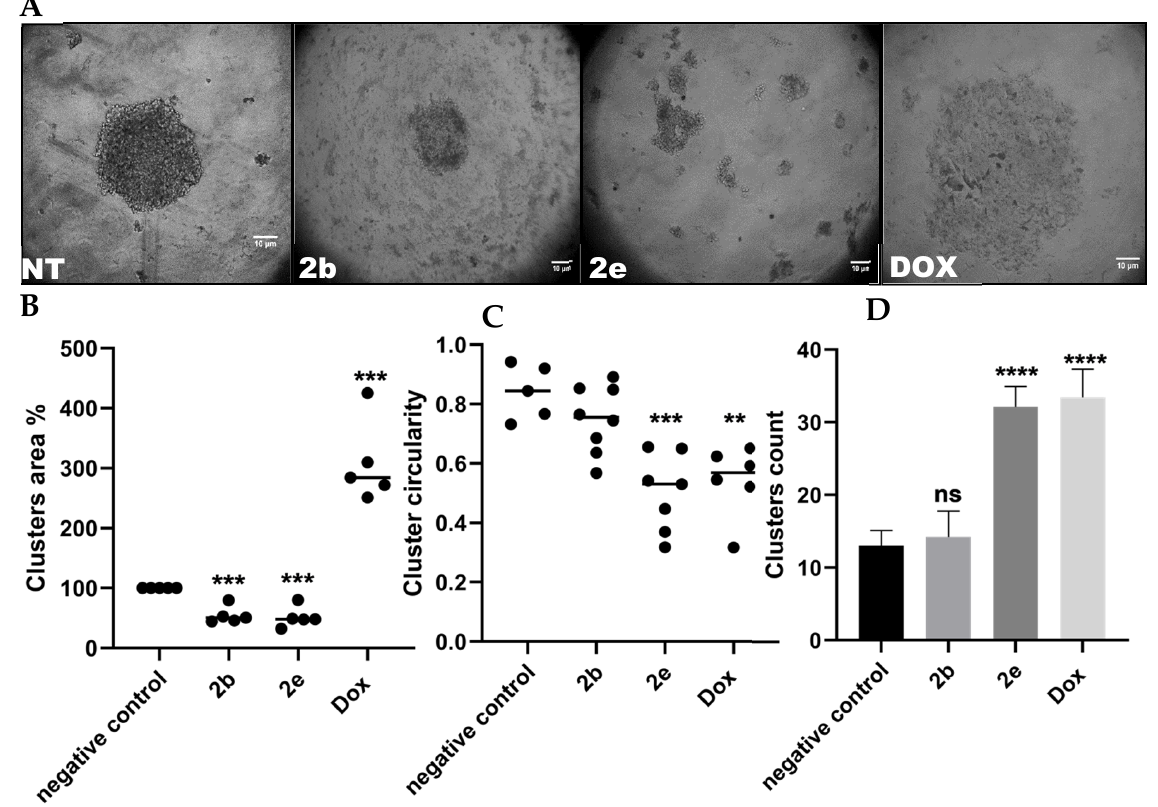
Figure 2. RHA-3 ( 2b ) and RHA-6 ( 2e ) perturb 3D hepatocellular spheroids’ formation. Images of cluster/s formed by Hep3B hepatocellular carcinoma in presence of 2b (17 µ g/mL) or 2e (17 µ g/mL) after 24 h of treatment compared to controls ( A ). Cluster percentage of occupied area relative to the negative control ( B ), cluster circularity ( C ), and cluster count ( D ). The non-treated cells are referred to as a negative control. At 100 µ g/mL, DOX was utilized as a positive control. The scale bar represents a distance of 10 µ m. Circularity scale: a value of 1 represents a perfect circle (ns: p > 0.05, **: p ≤ 0.01, ***: p ≤ 0.001, and ****: p ≤ 0.0001).